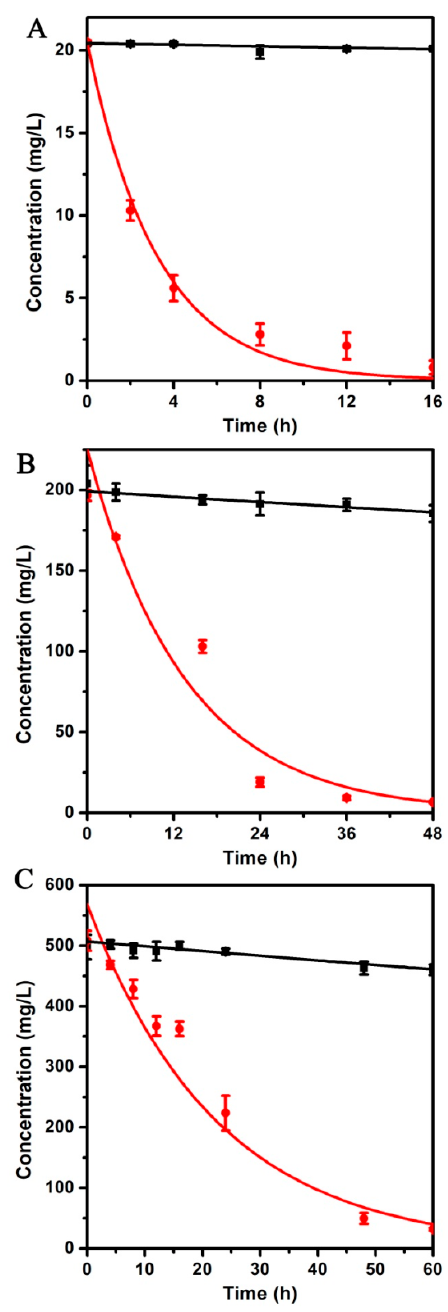
Figure 2. Degradation kinetics of chlorpyrifos with different initial concentration by strain X1 T . (A) 20 mg/L, (B) 200 mg/L, (C) 500 mg/L. The black line is the negative control (chlorpyrifos without strain X1 T ) and the red line is the positive control (chlorpyrifos with strain X1 T ). All values are means ± standard deviation of triplicate measurements.